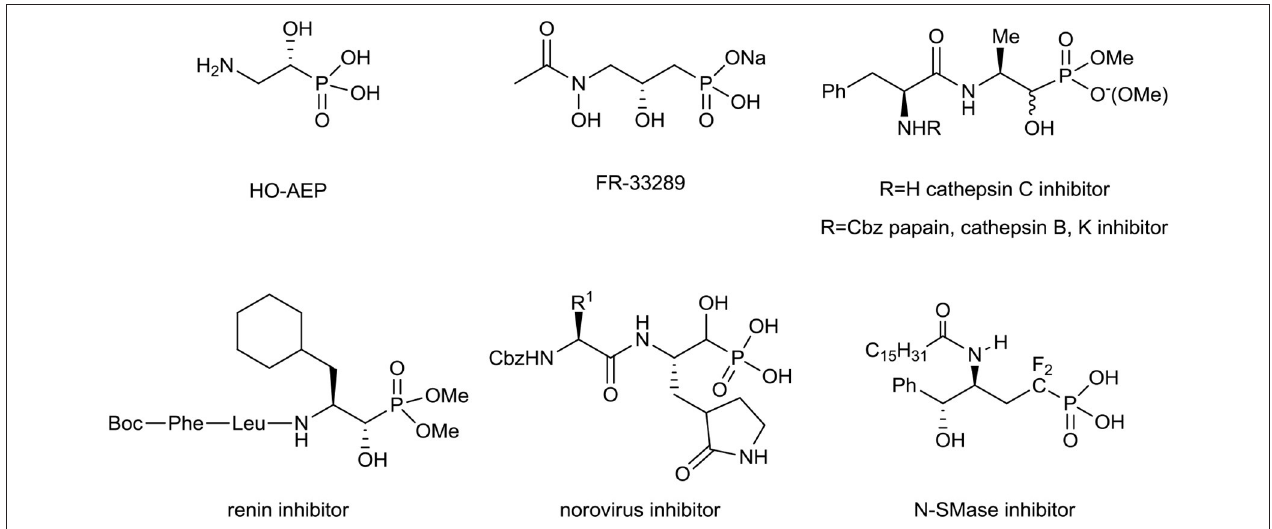
FIGURE 1 | Structures of different bioactive amino alcohol derivatives of alkylphosphonates.